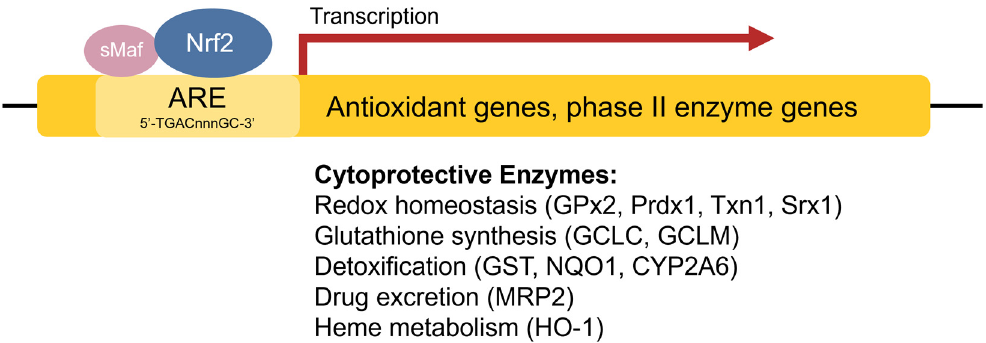
Figure 2. Transcriptional regulation of antioxidant genes by the ARE and Nrf2. Nrf2 heterodimer- izes with sMaf proteins and binds to the ARE found within the promoter regions of antioxidant and phase II enzyme genes to activate their transcription.